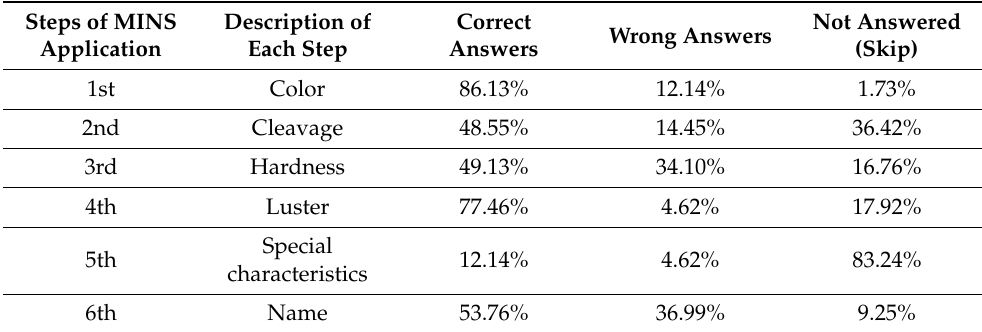
Figure 2. Sample photographs of minerals found by the students: ( a ) halite; ( b ) hematite. Table 2. Percentage of wrong and correct answers in each stage after the MINS application, com- menting only on the percentage of accepted answers.